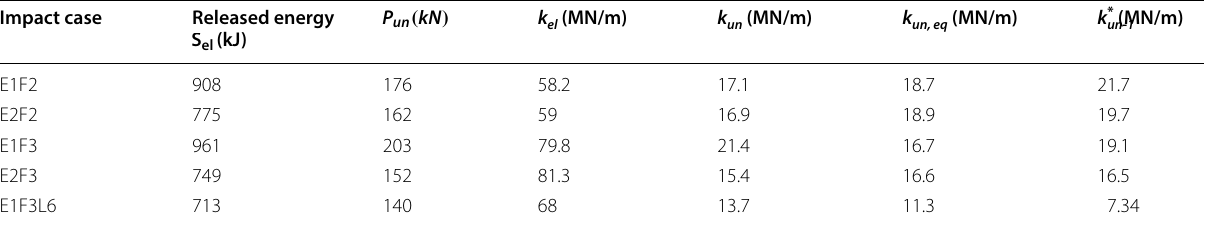
where k un - 1 * is the unload stiffness calculated from the fiber-based element model